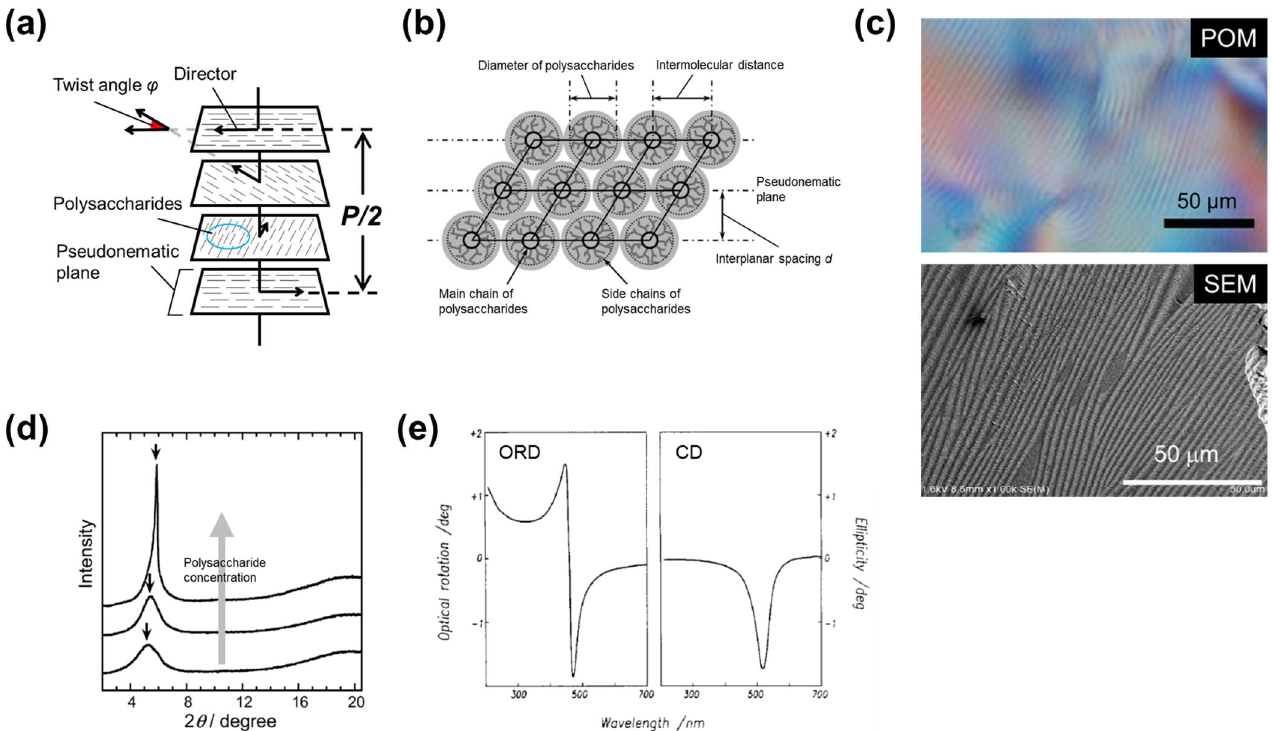
Figure 1. ( a ) Schematic that illustrates the helical pitch P , director, twist angle φ for a cholesteric liquid crystalline (ChLC) phase composed of polysaccharides. ( b ) Schematic illustrating the pseudonematic planes and interplanar spacing d for a short-range structure of a polysaccharide-based ChLC phase (reprinted with permission from [7] Copyright (2021) American Chemical Society). ( c ) Representative polarized optical microscope (POM) image of solution-state polysaccharide- based ChLC sample and scanning electron microscope (SEM) image of solid-state sample (reprinted with permission from [33] Copyright (2021) American Chemical Society). ( d ) Representative wide-angle X-ray diffraction profiles of solution- state polysaccharide-based ChLC samples with different polysaccharide concentrations (reprinted with permission from [7] Copyright (2021) American Chemical Society). ( e ) Representative circular dichroism (CD) and optical rotary dispersion (ORD) spectra of a right-handed ChLC sample (Reprinted with permission from [34] Copyright (2021) American Chemical Society).